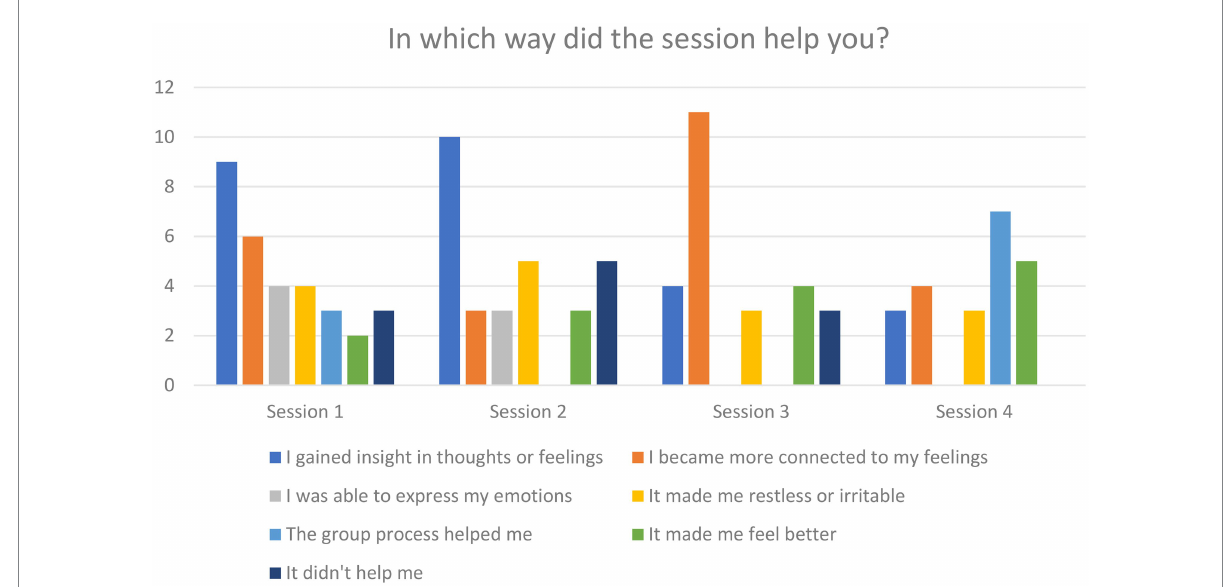
FIGURE 6 Responses to the open question per session (1–4) grouped by theme ( N =